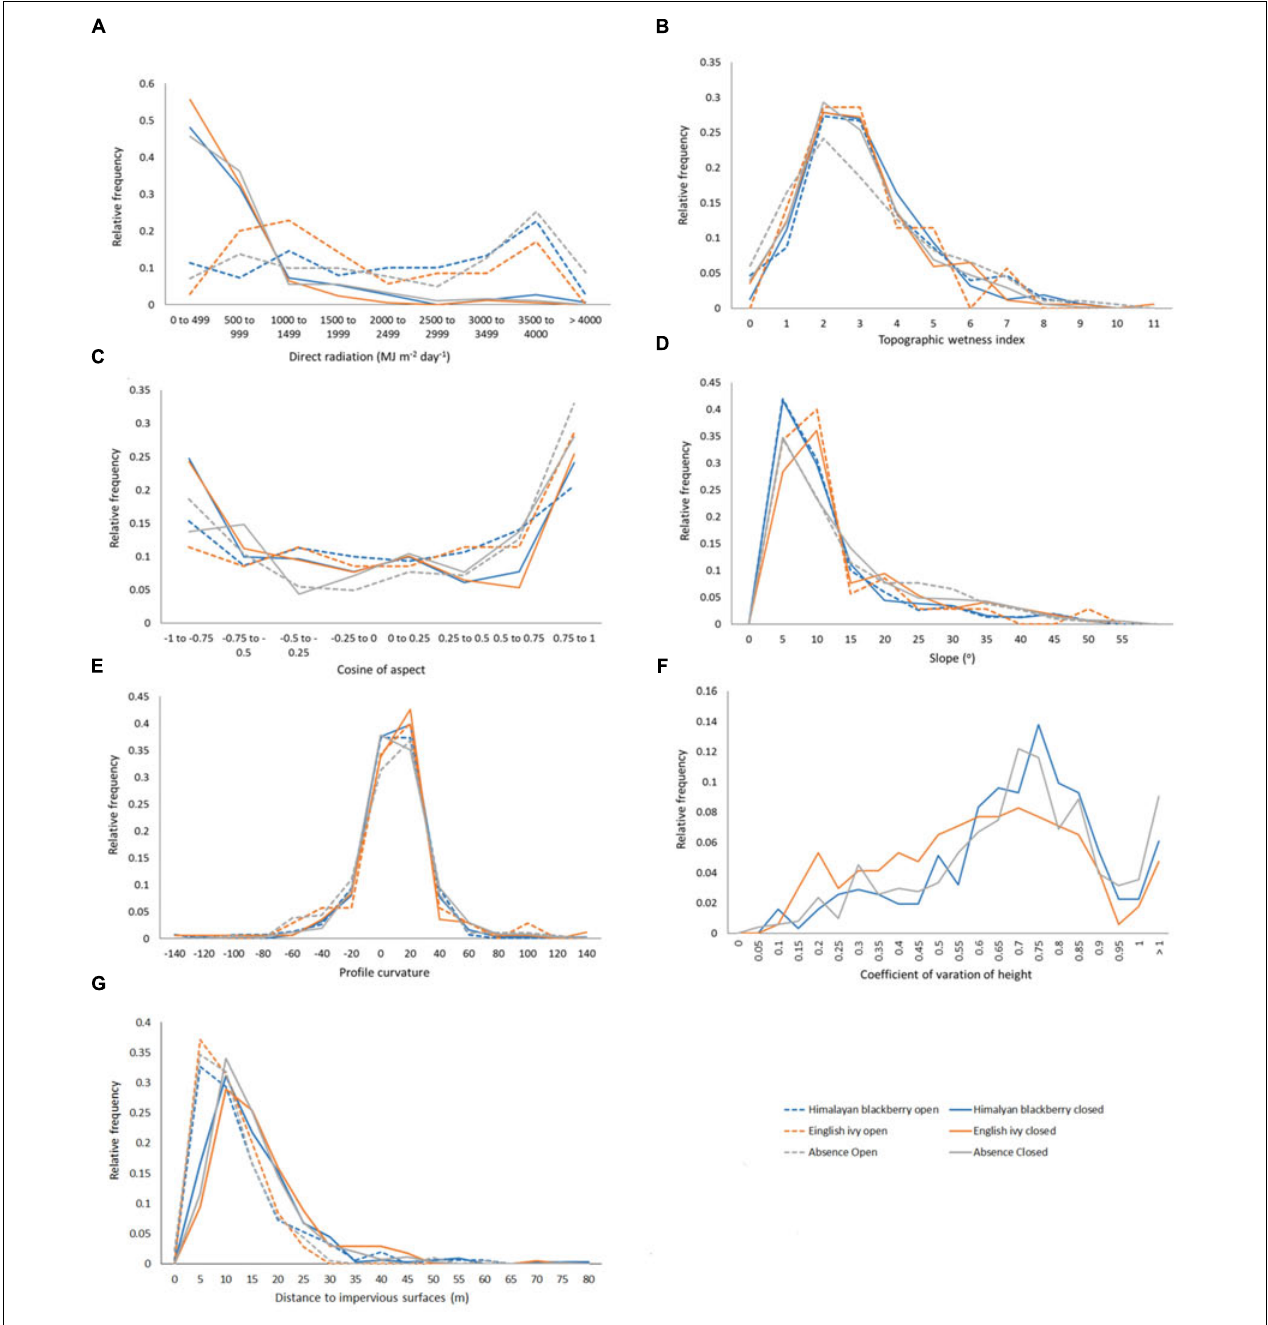
FIGURE 8 | Relative frequencies of values in Himalayan blackberry ( Rubus armeniacus ) and English ivy ( Hedera helix ) presence and absence plots for (A) direct radiation, (B) topographic wetness index, (C) cosine of aspect (“northness”), (D) slope, (E) profile curvature, (F) the coefficient of variation of height, and (G) the distances to impervious surfaces in Surrey, BC,